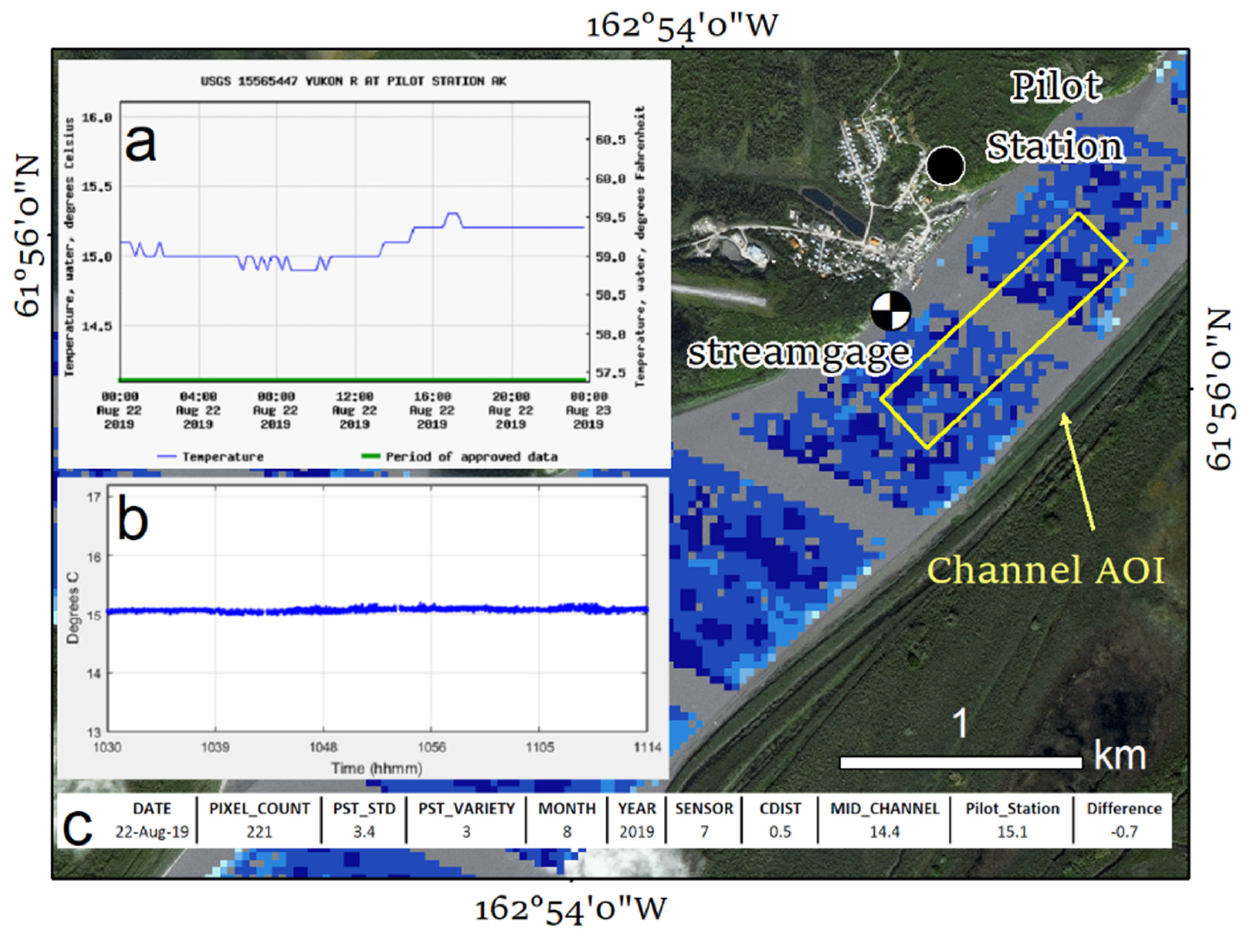
Figure 3. Example of concurrent measurements from: ( a ) automated streamgage system; ( b ) manual water temperature profile; and ( c ) remotely sensed provisional surface temperature (pST) estimate (MID_CHANNEL (°C)) and associated parameters (DATE, PIXEL_COUNT, PST_STD (°C), PST_VARIETY, MONTH, YEAR, SENSOR, CDIST (km), Pilot Station (°C), Difference (°C)).